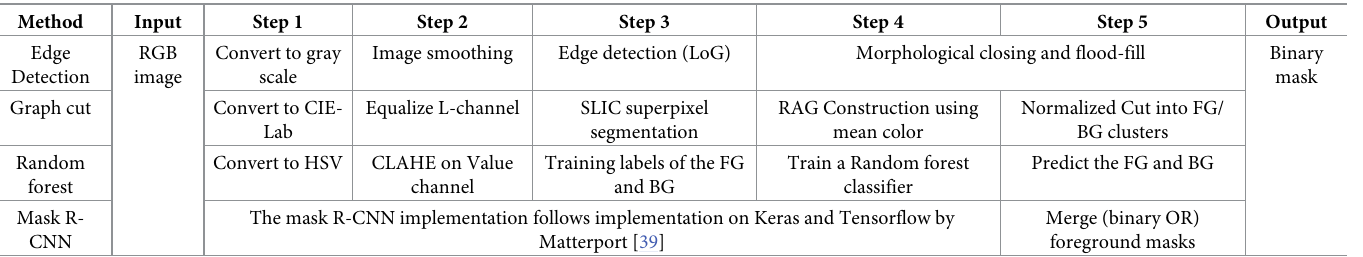
Table 1. Steps for each segmentation algorithm.